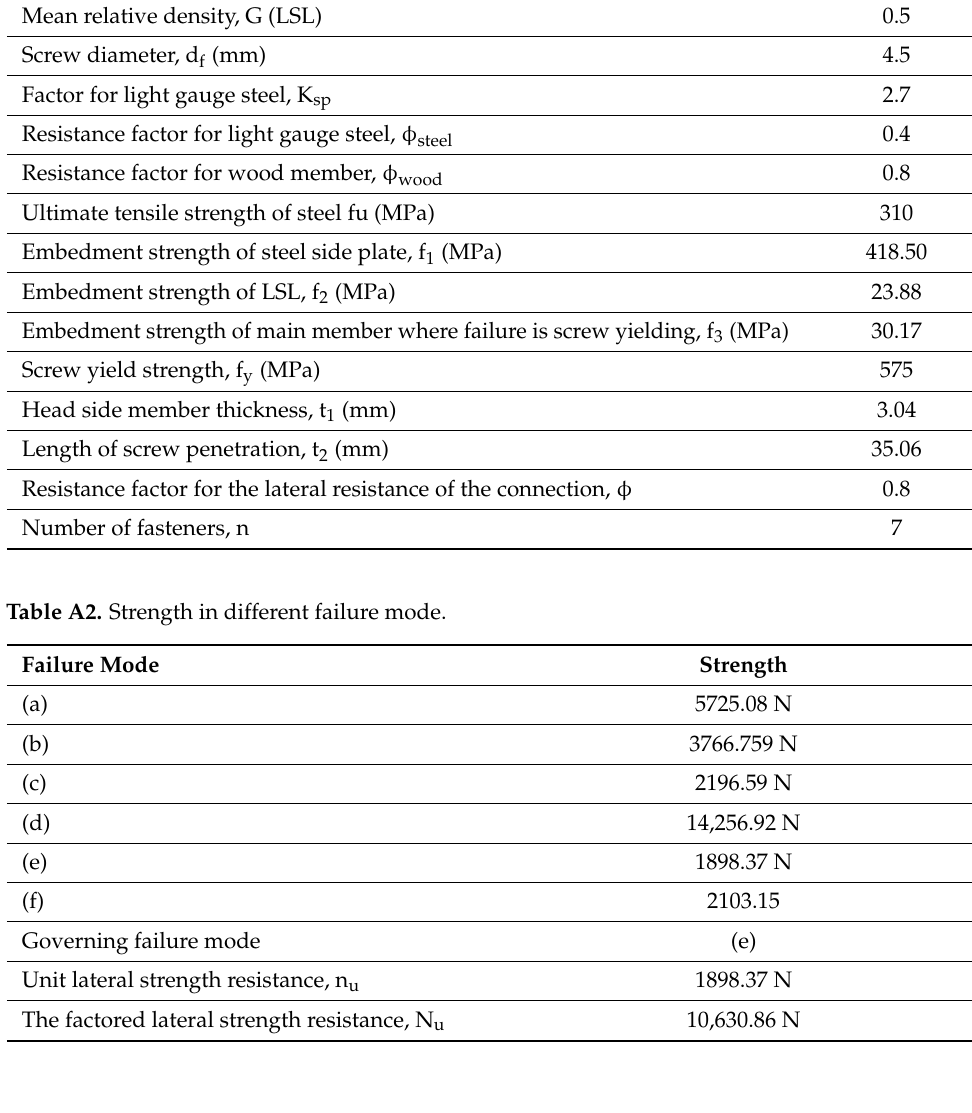
Table A1. Input parameters of the connection analysis.